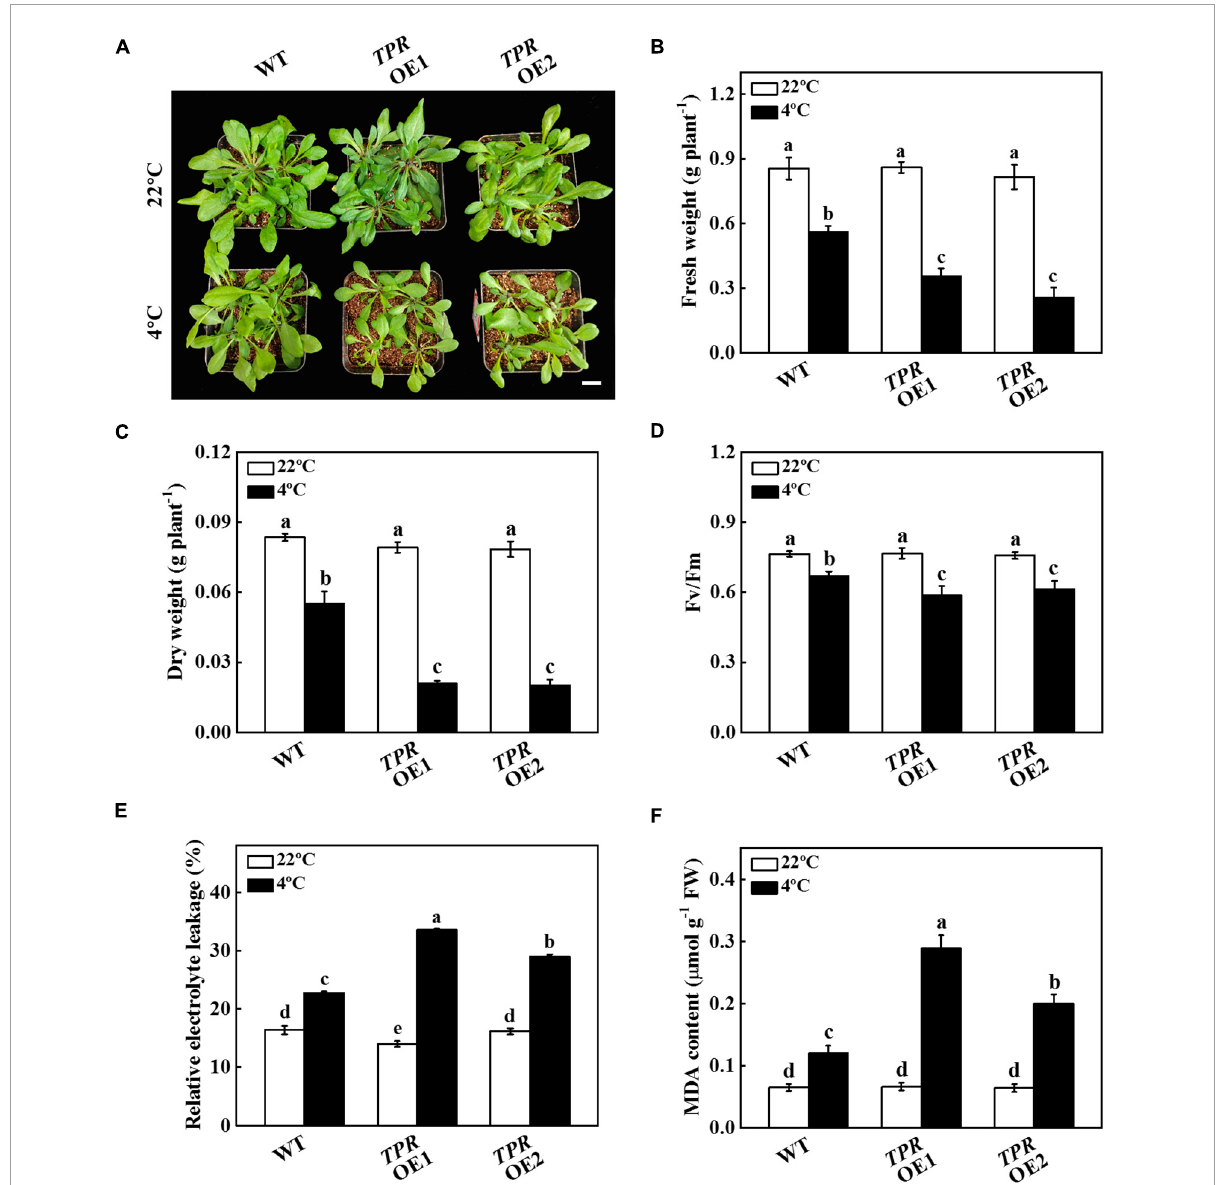
FIGURE4 Functional analysis of TPR in response to cold stress. (A) Overexpression of cucumber TPR in Arabidopsis increased sensitivity to cold stress. Bar: 1 cm. (B) Fresh weight. (C) Dry weight. (D) The maximum quantum yield of photosystem II (Fv/Fm). (E) Relative electrolyte leakage (REL). (F) Malondialdehyde (MDA) content in leaves. Arabidopsis seedlings were treated with cold stress at 4 ◦ C for 7 d, and the phenotype, fresh weight, dry weight, Fv/Fm, REL, and MDA content were measured. The results represent the mean ± SD ( n = 3). Means with the same letter did not significantly differ at P < 0.05 according to Tukey’s test. FW, fresh weight.